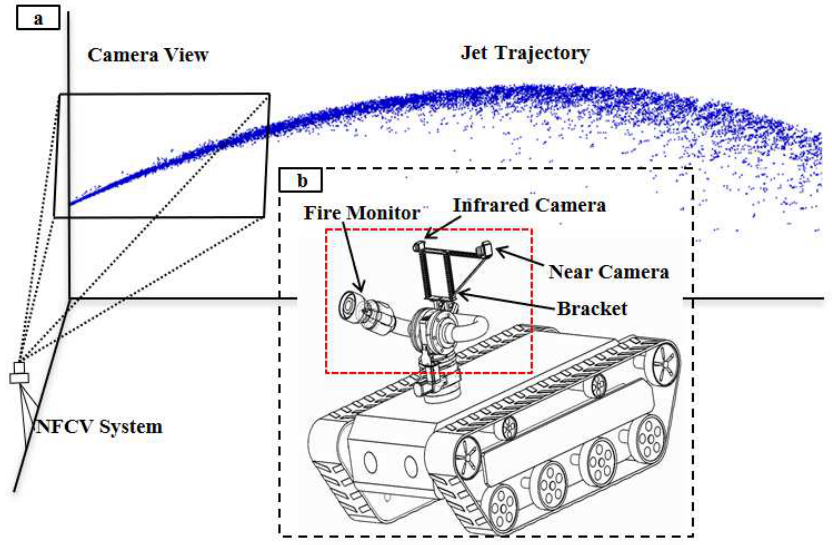
Figure 1. The structure of the near-field computer vision (NFCV) and fire robot. ( a ) NFCV; ( b ) fire robot equipped with fire monitor, red frame represents the visual